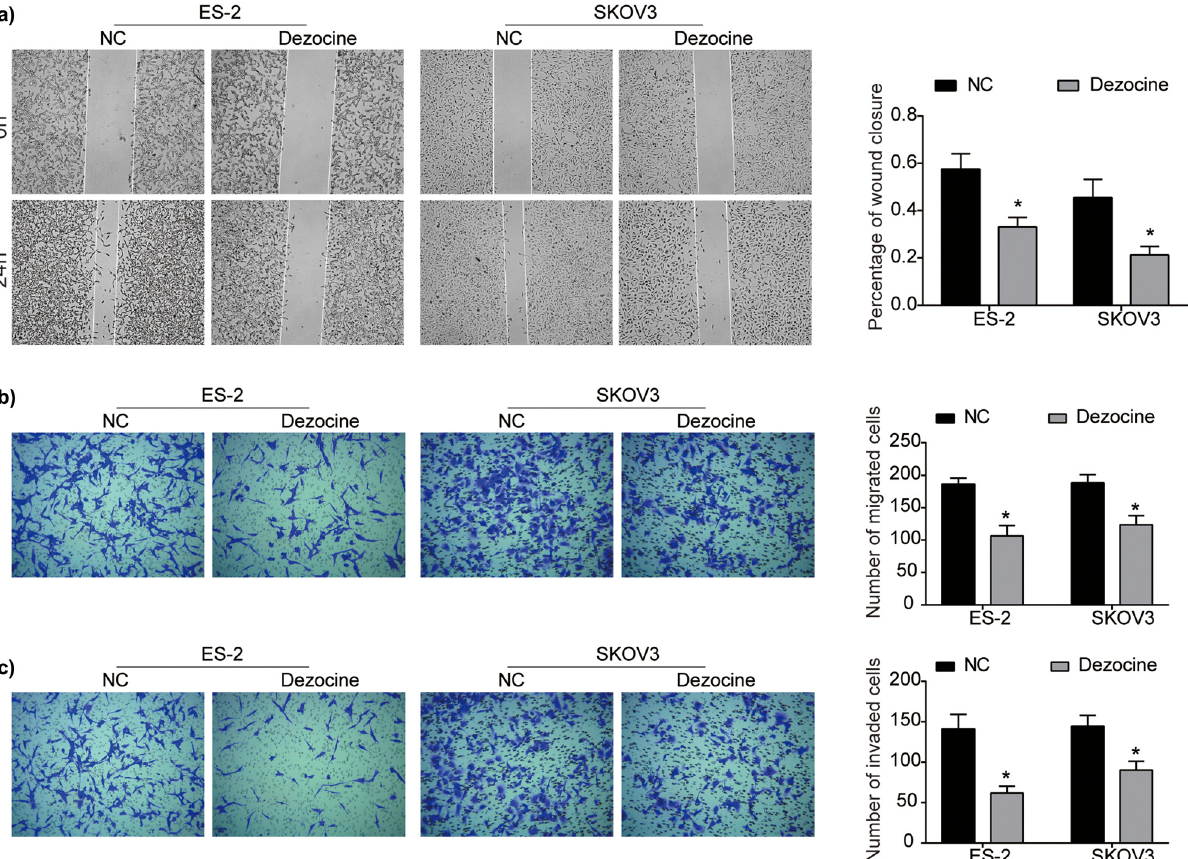
Figure 2: Dezocine suppresses the migration and invasion of ovarian cancer cells. ( a ) After cells were treated with dezocine for 0 and 24 h, wound - healing assay was performed to measure the wound closure. ( b and c ) Cell migration ( b ) and invasion ( c ) were measured using transwell assay in ES - 2 and SKOV3 cells treated with dezocine for 24 h. * P <